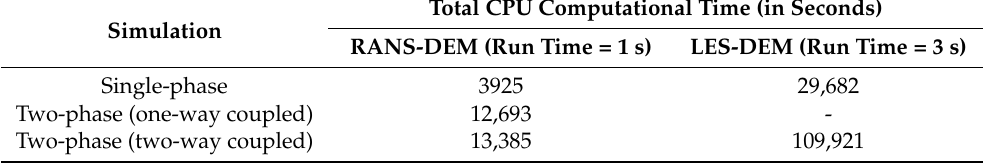
Table 3. Total CPU computational